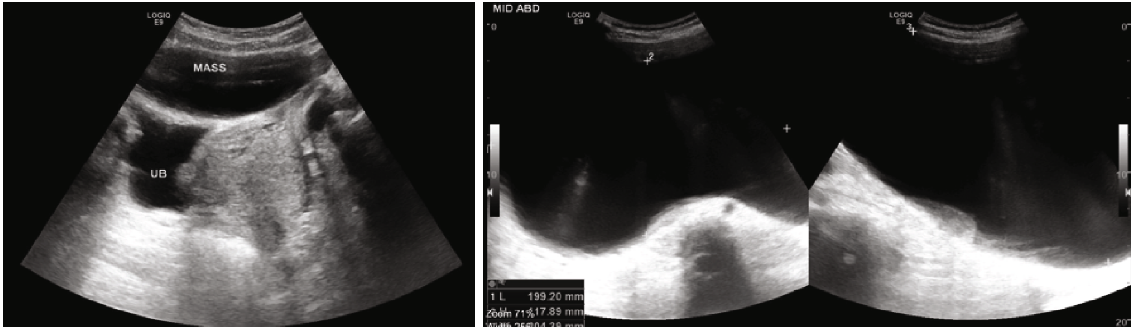
Figure 2: Abdominal and pelvic ultrasonography showed a huge cystic lesion with clear fl uid